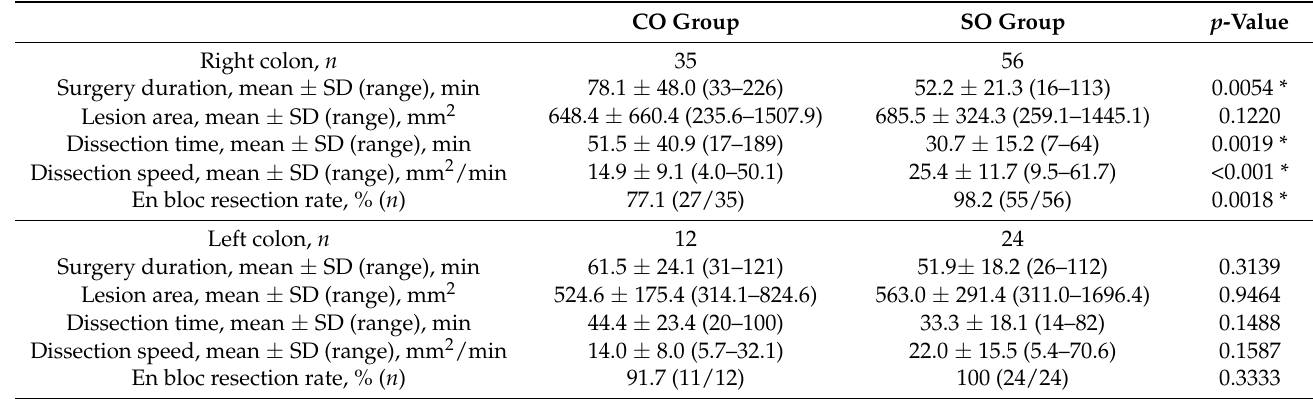
Table 3. Separate analysis for the left colon and the right